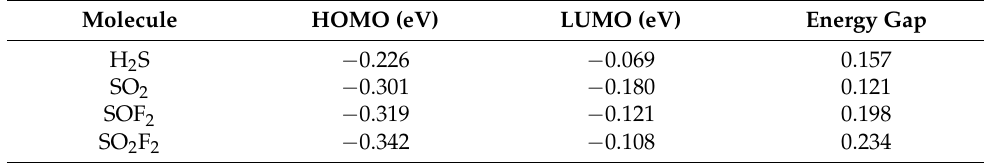
Table 2. HOMO/LUMO energies of the four gas